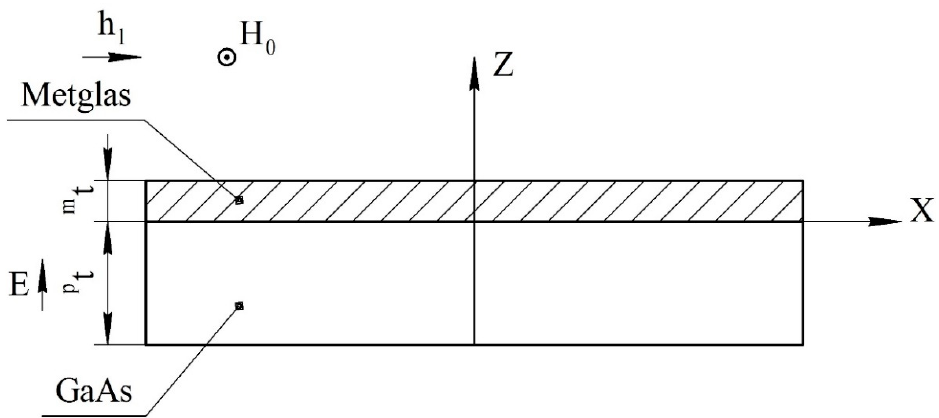
Figure 11. Theoretical dependence of the ME voltage coefficient on the volume fraction of the pie- zoelectric material for ME structure Metglas/GaAs of the longitudinal-shear mode.